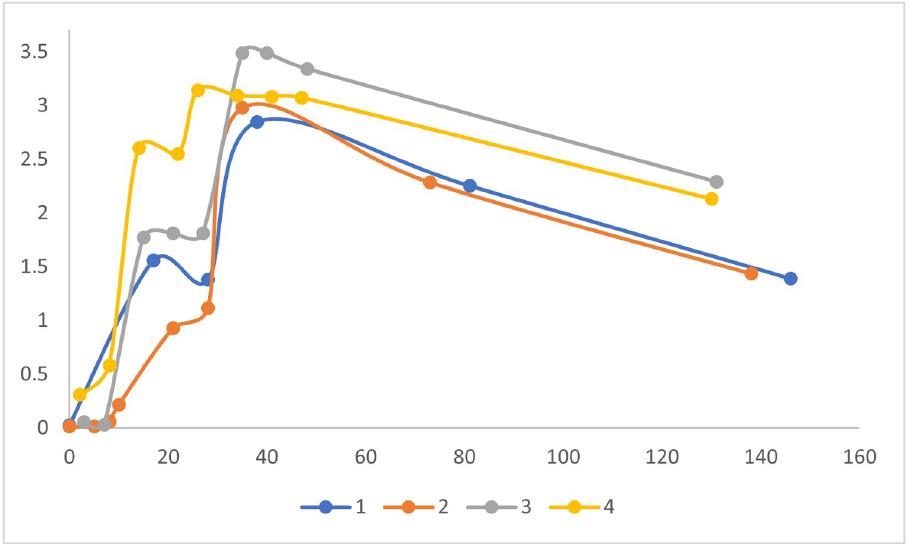
Fig 1. Time course of spike antigen-specific IgG response to COVID-19 mRNA vaccine. ELISAs were performed on serum from 4 subjects described in Table 1, at different time points after vaccination (X-axis, days). Serum IgG levels are proportional to ELISA optical density values (Y-axis). Each symbol represents average ELISA data for a single subject at a single time point. Scatter plots were fitted with a moving average trend line. Note 2 nd vaccine dose was at day 28 for subjects 1–3, and day 21 for subject